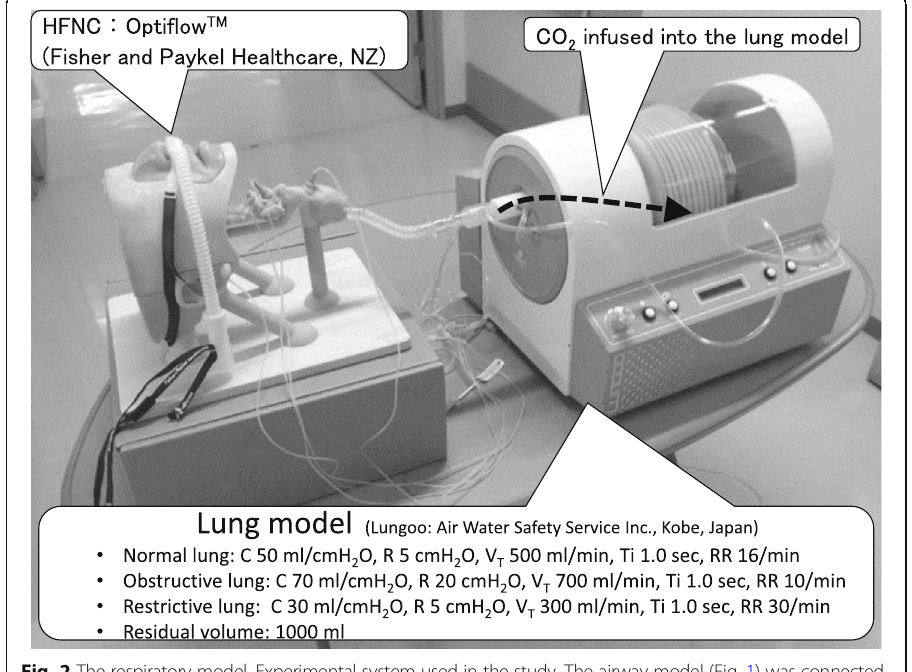
Fig. 2 The respiratory model. Experimental system used in the study. The airway model (Fig. 1) was connected to the lung model. The physiological dead space was adjusted to 3 mL/kg. The respiratory patterns of the lung model could be changed, and the model had pressure sensors to measure the internal pressure. Sampling tubes were connected to the capnogram at each site